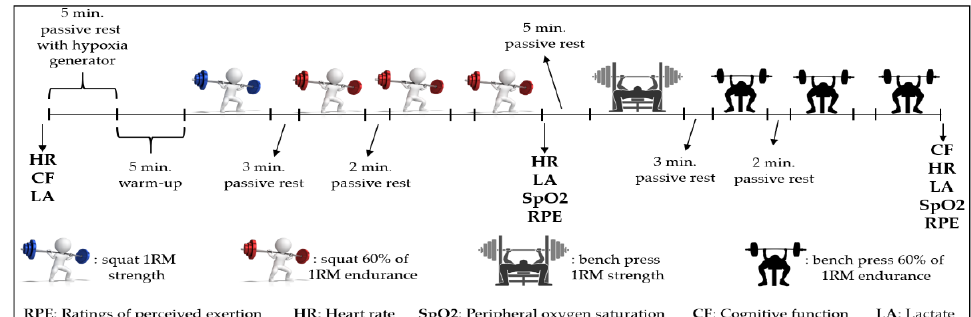
Figure 1. Schematic representation of the experimental